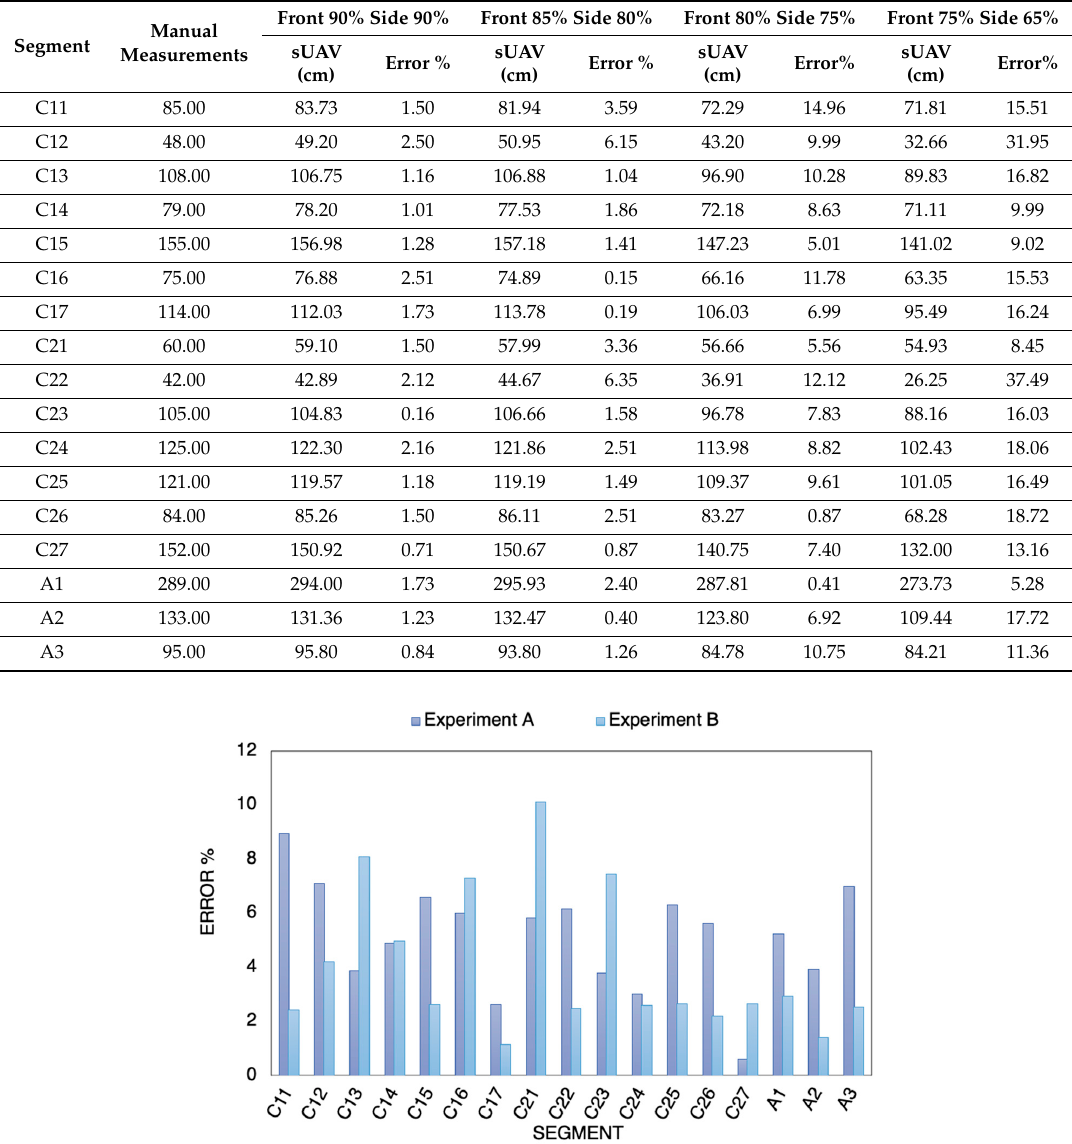
Table 6. Manual measurements vs. sUAV measurements of the accident scene with varying percentages of frontal and lateral overlaps.